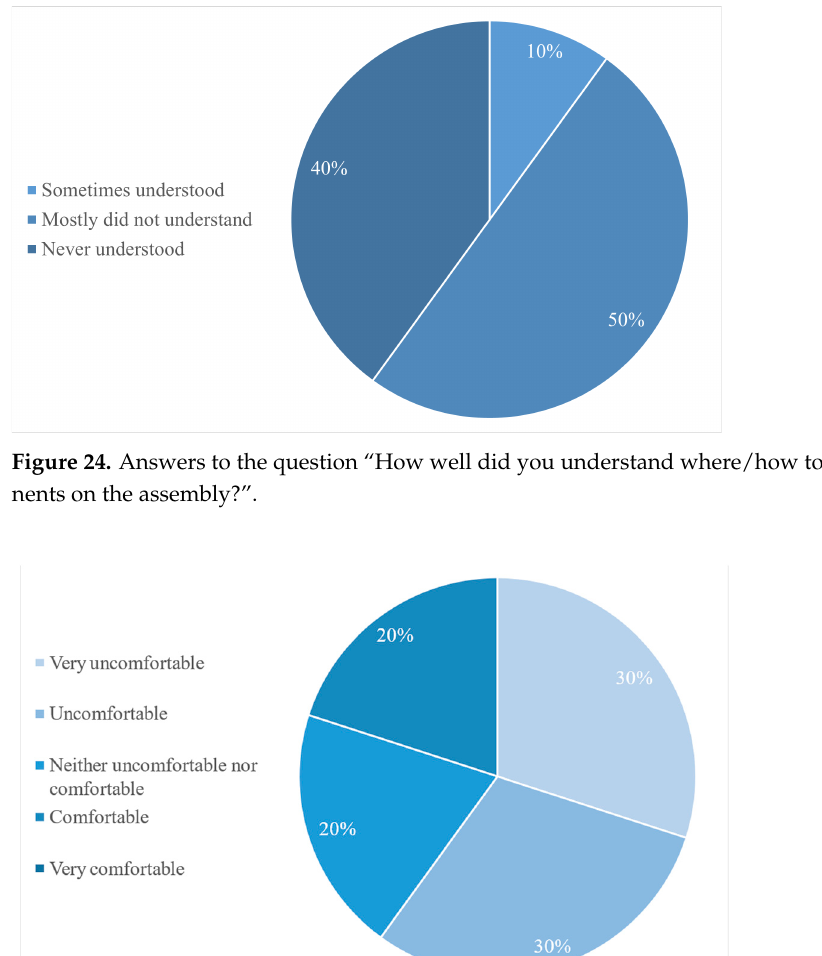
Figure 25. Answers to the question “How comfortable did you find the assembly validation procedure?”.